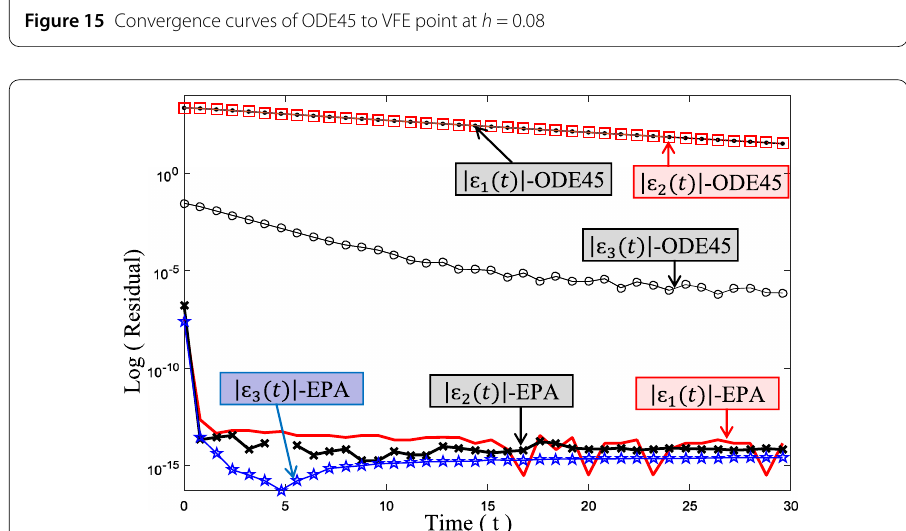
Figure 15 Convergence curves of ODE45 to VFE point at h = 0.08